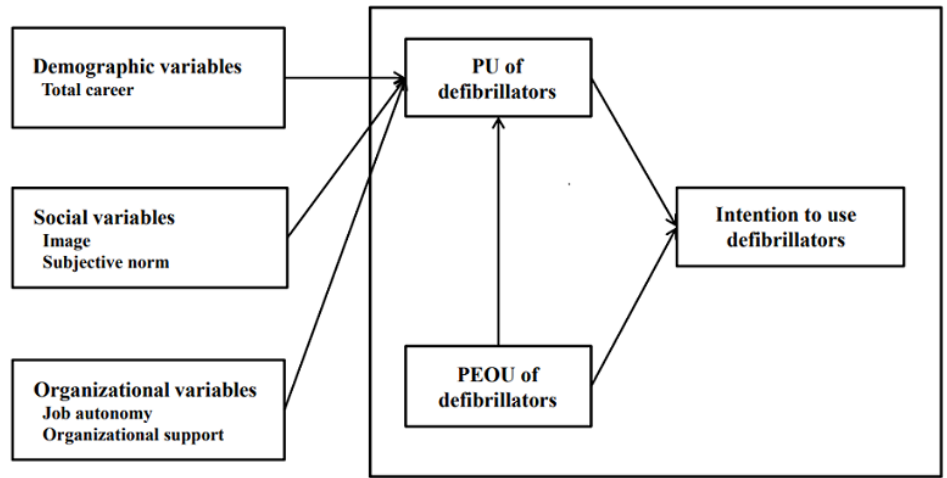
Figure 1. Research framework on intention to use defibrillators of clinical nurses based on TM2 model.